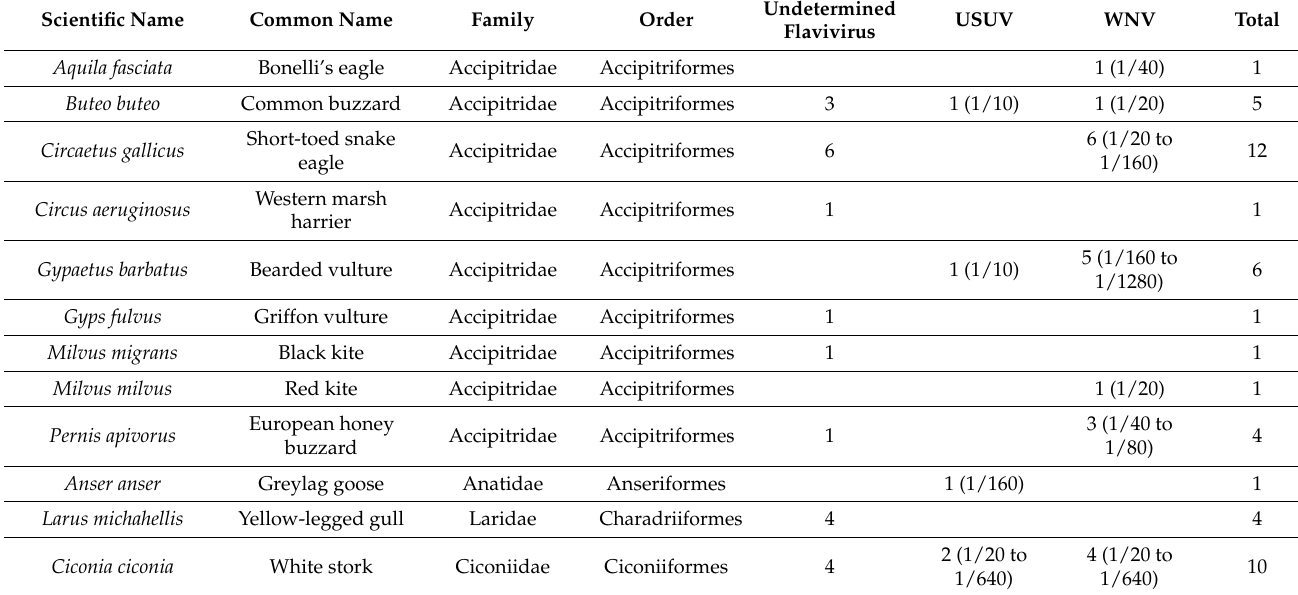
Table 1. Detection of antibodies against flaviviruses in sera from different bird species by MNT. In brackets MNT titer (or range if more than one positive sample).